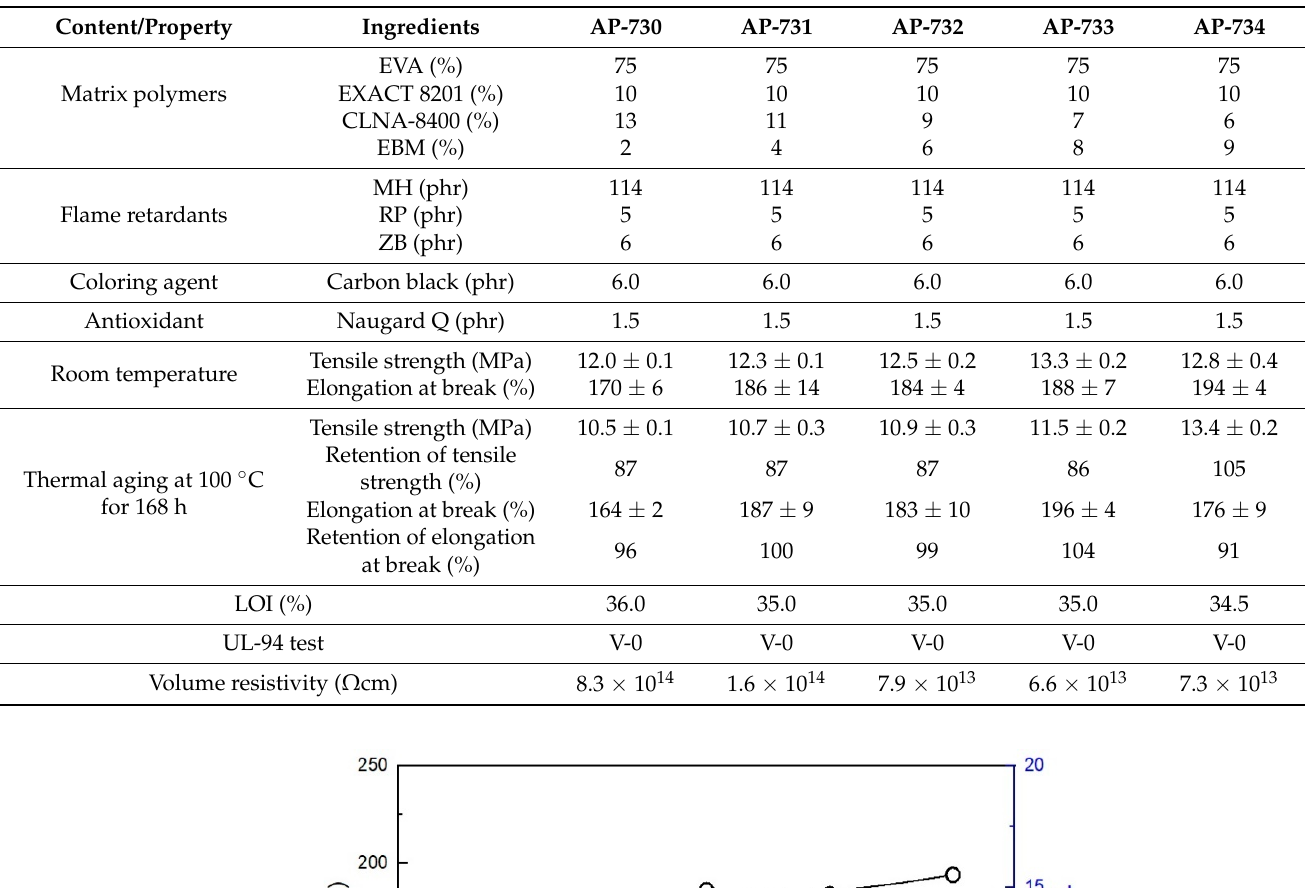
Table 5. EVA/EXACT 8201/CLNA-8400/125 phr flame-retardant (MH+ZB+RP) formulations as a function of EBM content (Second).